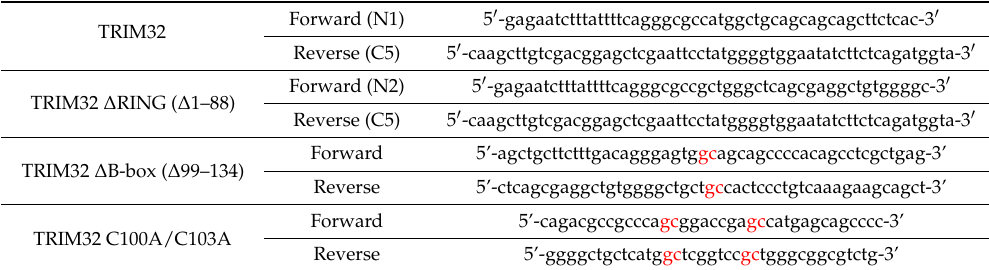
Table 1. List of primers used in this study. For mutagenizing primers, bases bordering the deletion ( ∆ B-box) or corresponding to the mutations (C100A/C103A) are in